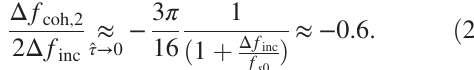
and the coherent shift Δ f to the total synchrotron frequency shift 2 Δ f inc coh ; 2